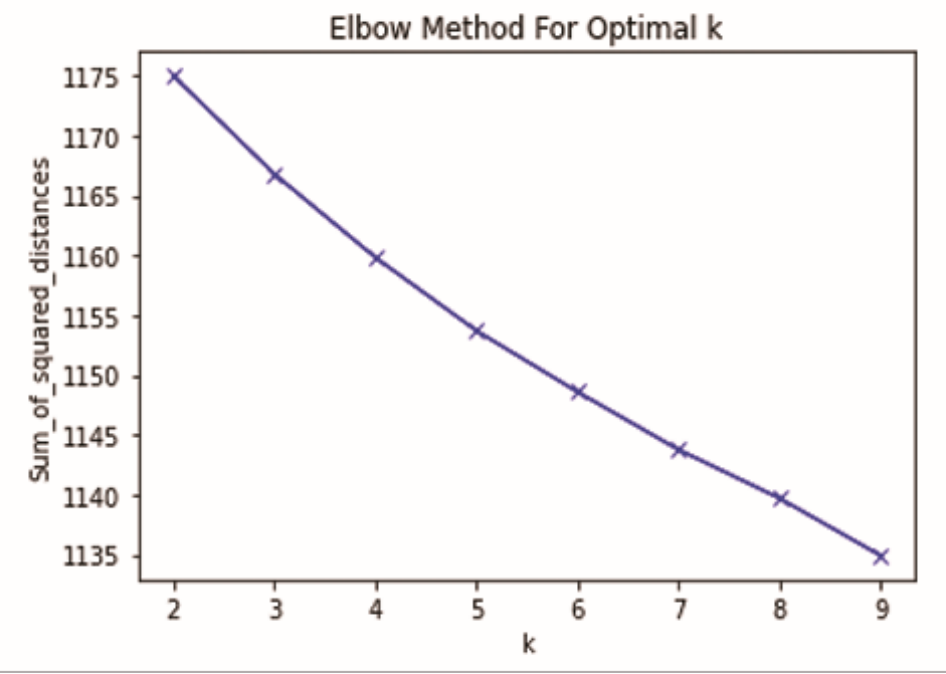
Figure 10. Elbow method for optimal k own elaboration,.